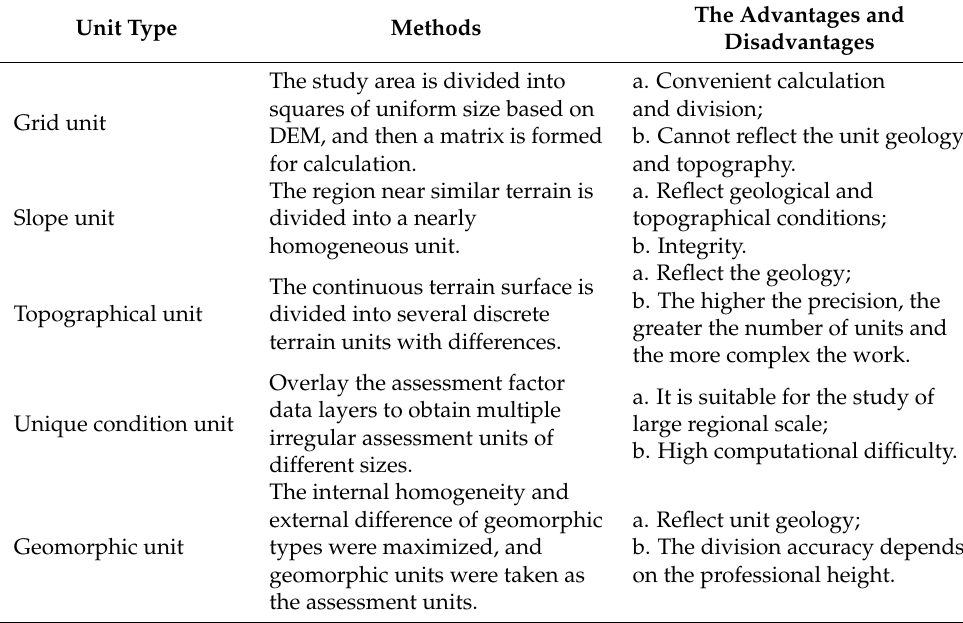
Table 7. Type of the assessment unit.